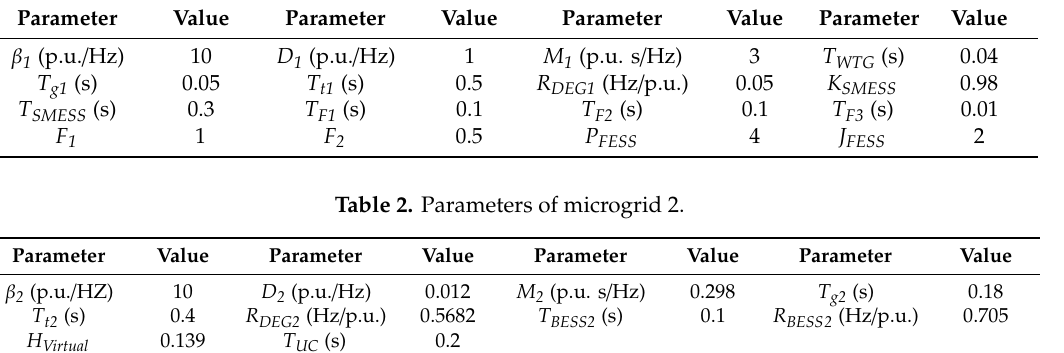
Table 1. Parameters of microgrid 1.